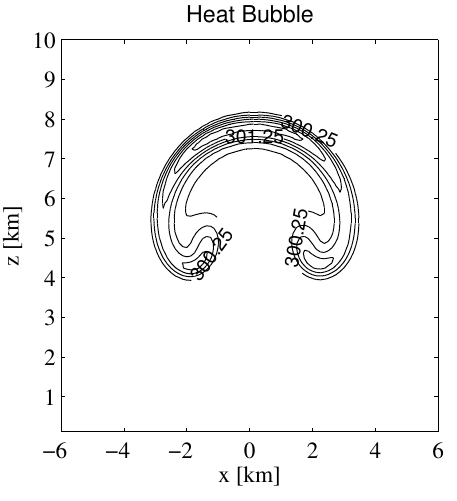
Fig. 2. Result for the heat bubble test case after 1000 s (contours: pot. temp. 0 . 25K)